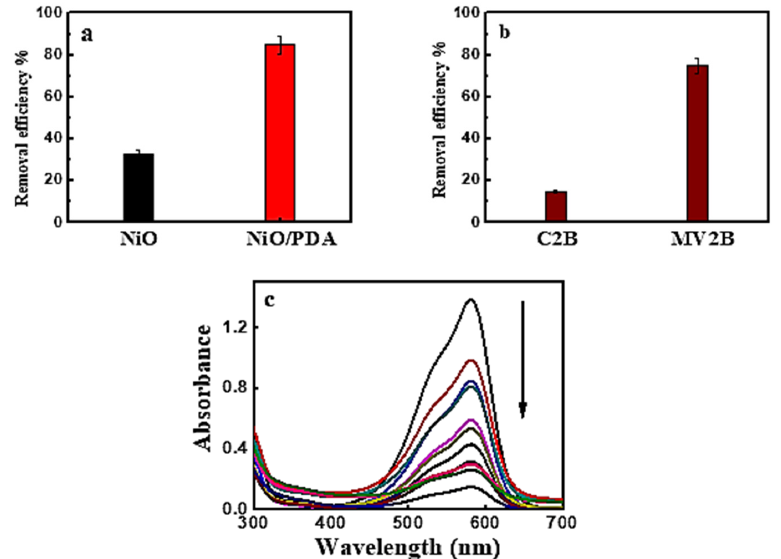
Figure 4. ( a ) Removal efficiency of MV2B by NiO and NiO/PDA, ( b ) removal efficiency of Chromo- trope 2B and Methyl Violet 2B by NiO/PDA, NiO/PDA = 0.05 g, (MV2B) o = 2.95 mg L − 1 , at 30 °C ( c ) UV-Vis spectral traces of MV2B with NiO/PDA = 0.05 g at 30 °C.